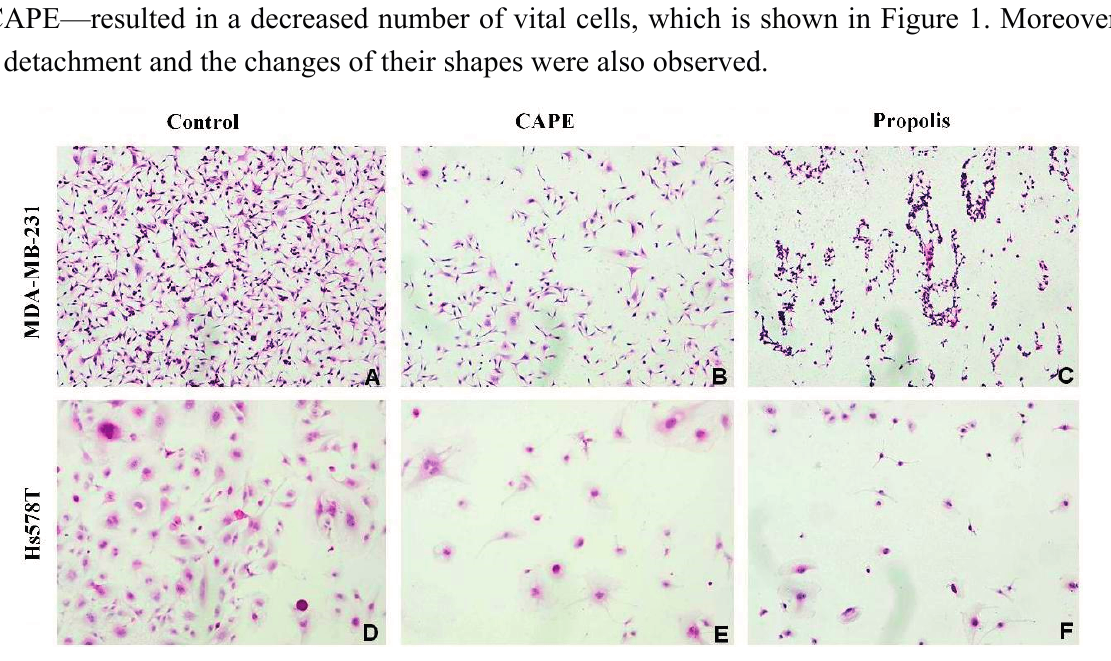
Figure 1. Morphological and cytological features of triple-negative breast cancer (TNBC) MDA-MB-231 ( A – C ) and Hs578T ( D – F ) treated with 0.2% DMSO solution